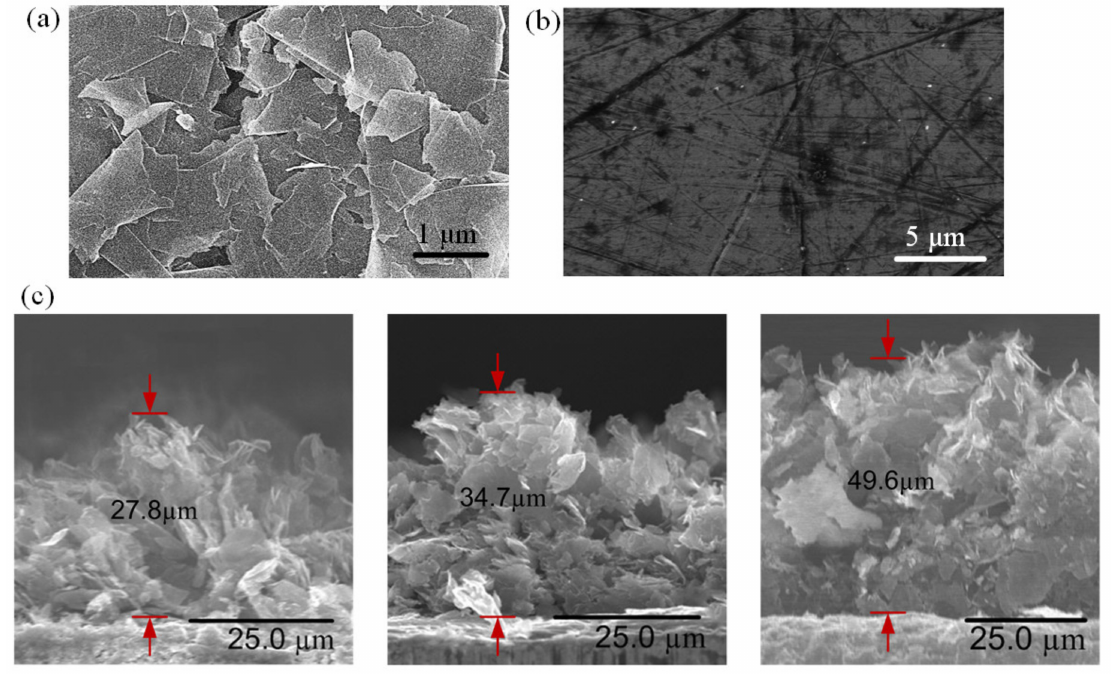
Figure 4. FESEM images of ( a ) GNP-coated, and ( b ) uncoated copper surfaces. ( c ) FESEM images of cross-sectional view of GNP nano-wicks with thicknesses of 27.8 µ m, 34.7 µ m, and 49.6 µ